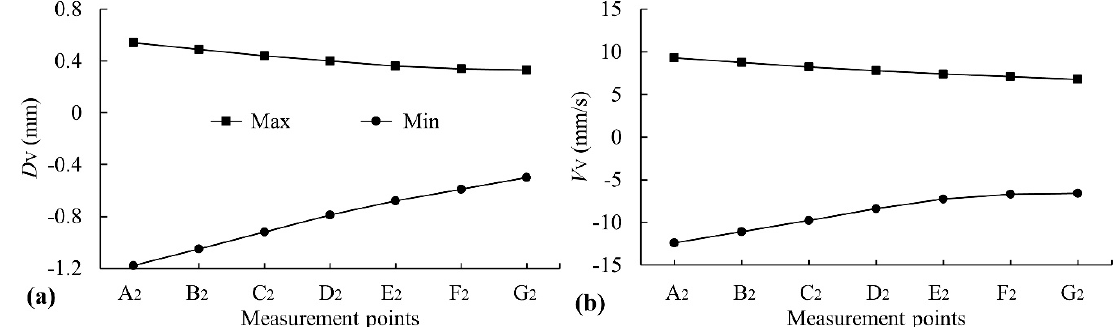
Figure 11. Maximum and minimum value of the D V and V V of seven measurement points (A 2 , B 2 , C 2 , D 2 , E 2 , F 2, and G 2 ) in Wall_2 of T2: ( a ) maximum and minimum value of the D V ; ( b ) maximum and minimum value of the V V .